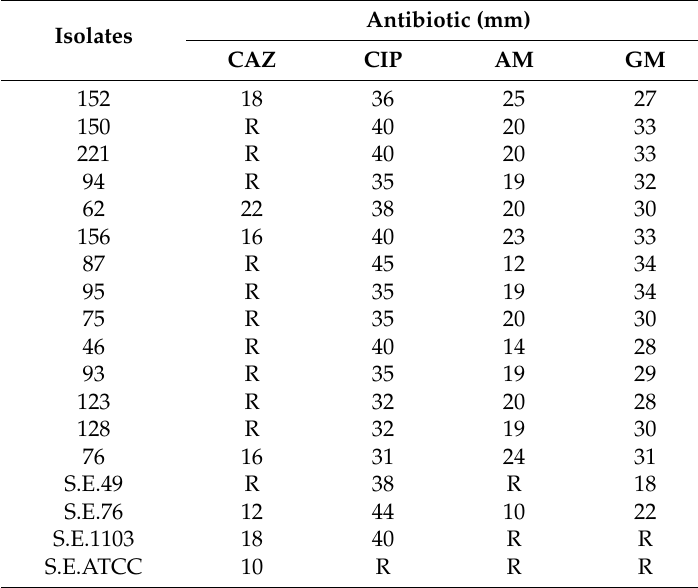
Table 2. The inhibitory growth zones by the studied isolates exposed to antibiogram discs. Antibiotic (mm) Isolates CAZ CIP AM